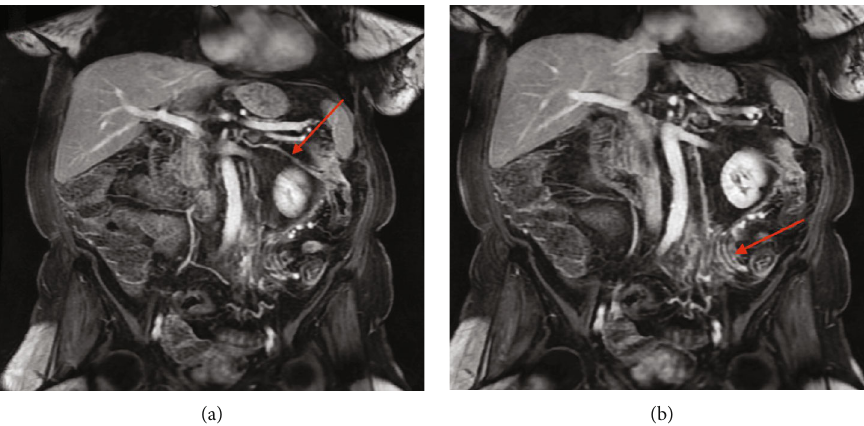
Figure 3: MRA of the abdomen with and without gadolinium 7 weeks after initial presentation. Coronal T1-weighted fat-suppressed VIBE late arterial phase postcontrast images display (a) a prominent marginal artery connecting the middle colic artery to the left colic artery (arrow) and also reveal (b) a cluster of early draining veins in the region of the sigmoid colon mesentery